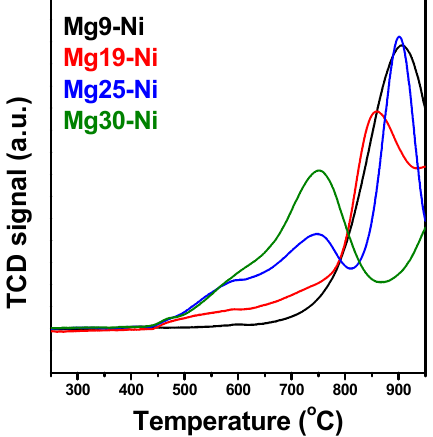
Figure 5. H 2 -TPR of Mg-aluminates after Ni loading with calcination.